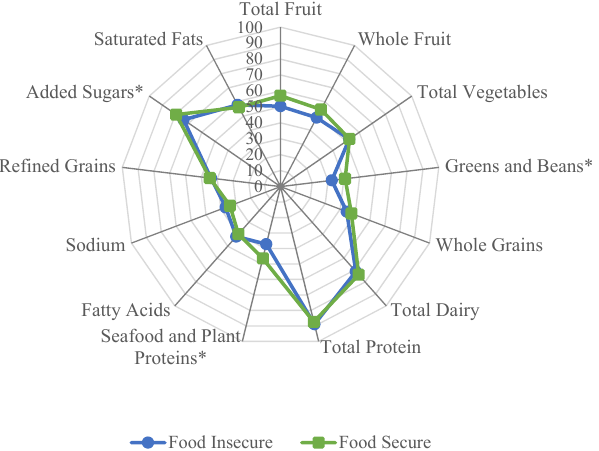
Figure 1. Radar plot visualization of average Healthy Eating Index-2015 component scores contributing to the total score in food insecure and food secure children. Significant differences ( p < 0.05) in mean component scores between food insecure and food secure children are denoted with an asterisk.